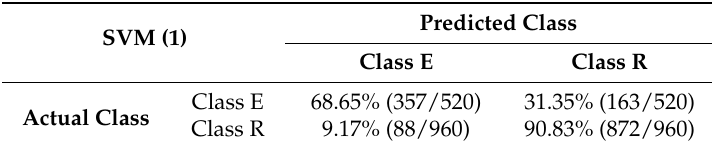
Table 6. Confusion matrices for cross-validation.